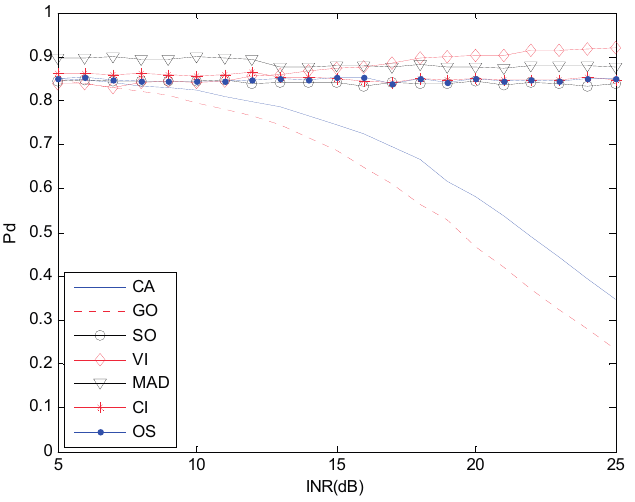
Figure 9. P vs . INR in the non-homogenous environment, r(0,1). d